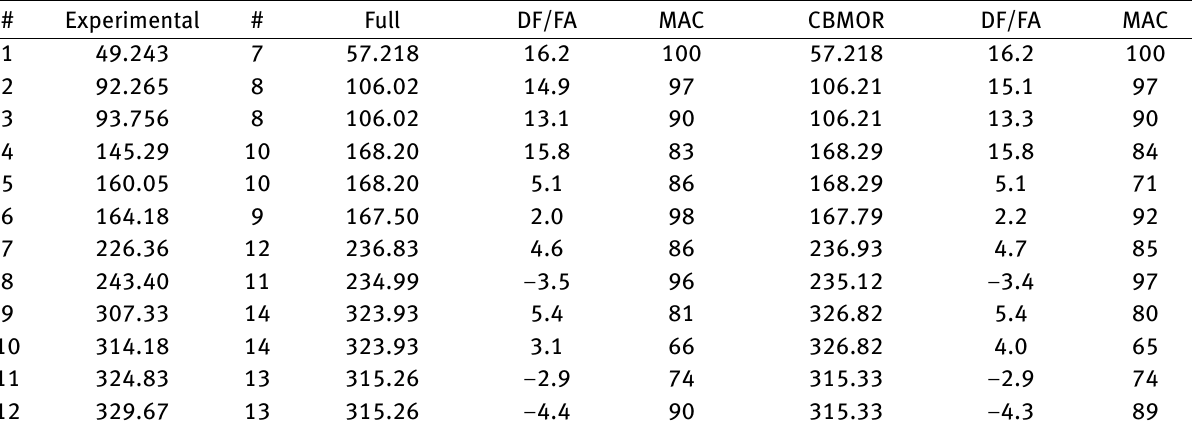
Table 1: Full and reduced model results versus experimental results [17]. # Experimental # Full